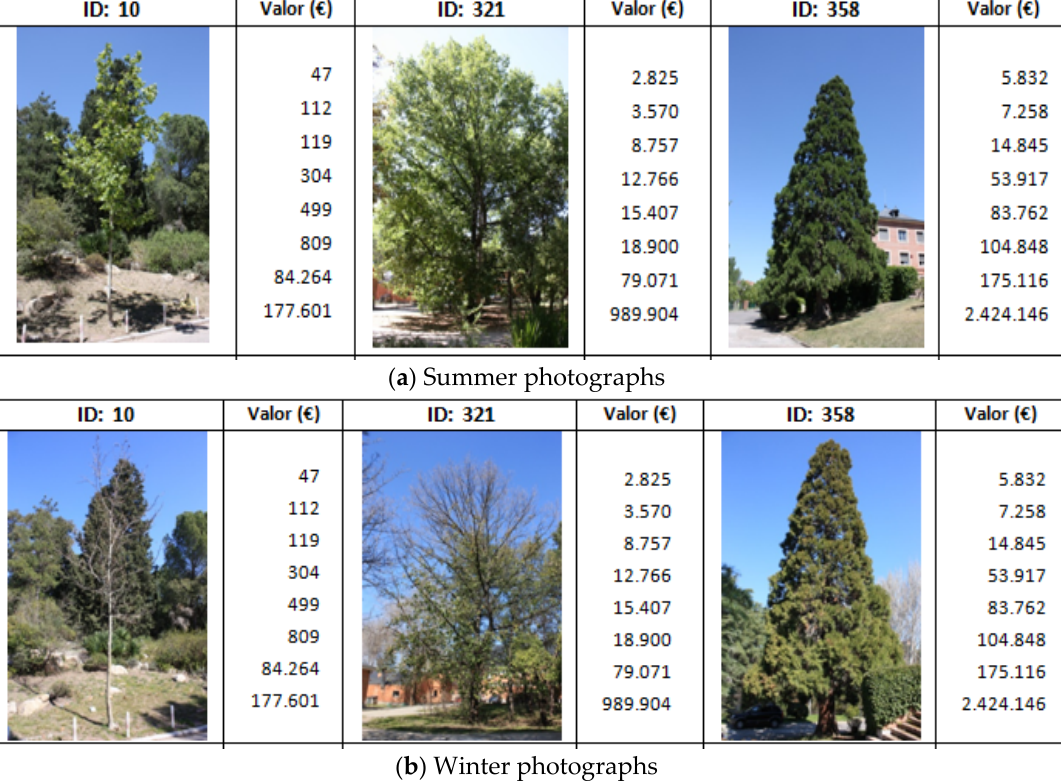
Figure 1. View of the survey with three of the specimens presented for evaluation through photographs taken in summer (S) ( a ) and winter (W) ( b ).